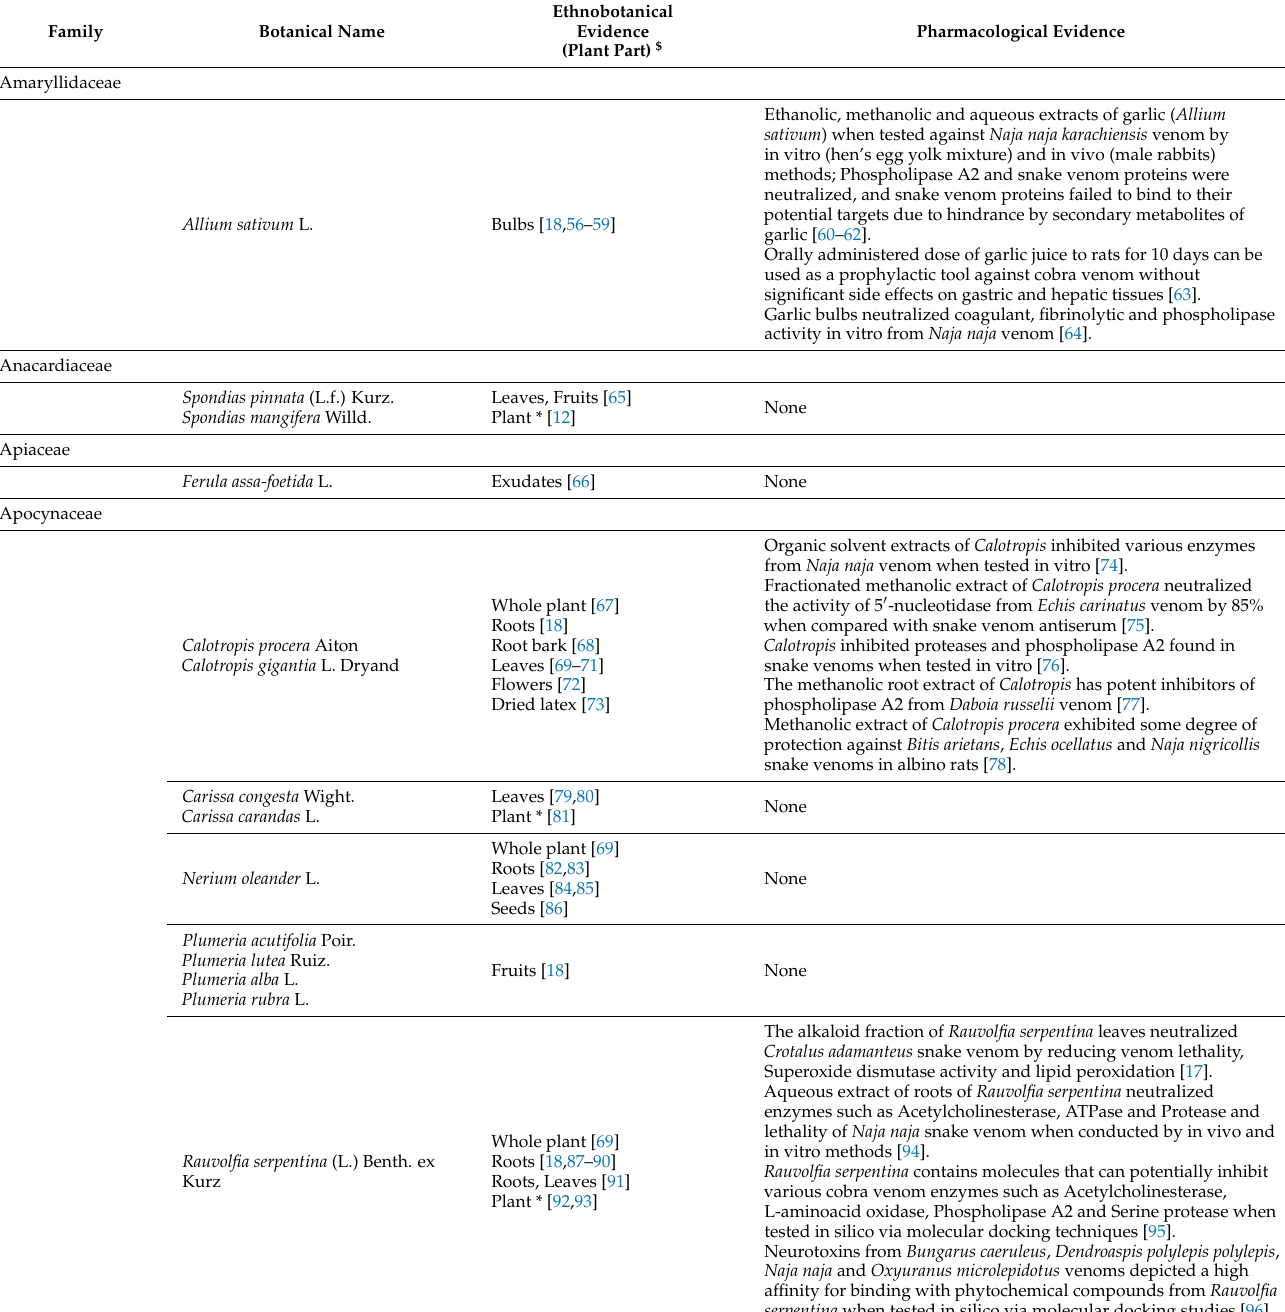
Table 4. Ethnobotanical and pharmacological evidence of plant species used in the treatment of snake envenomation in the modern